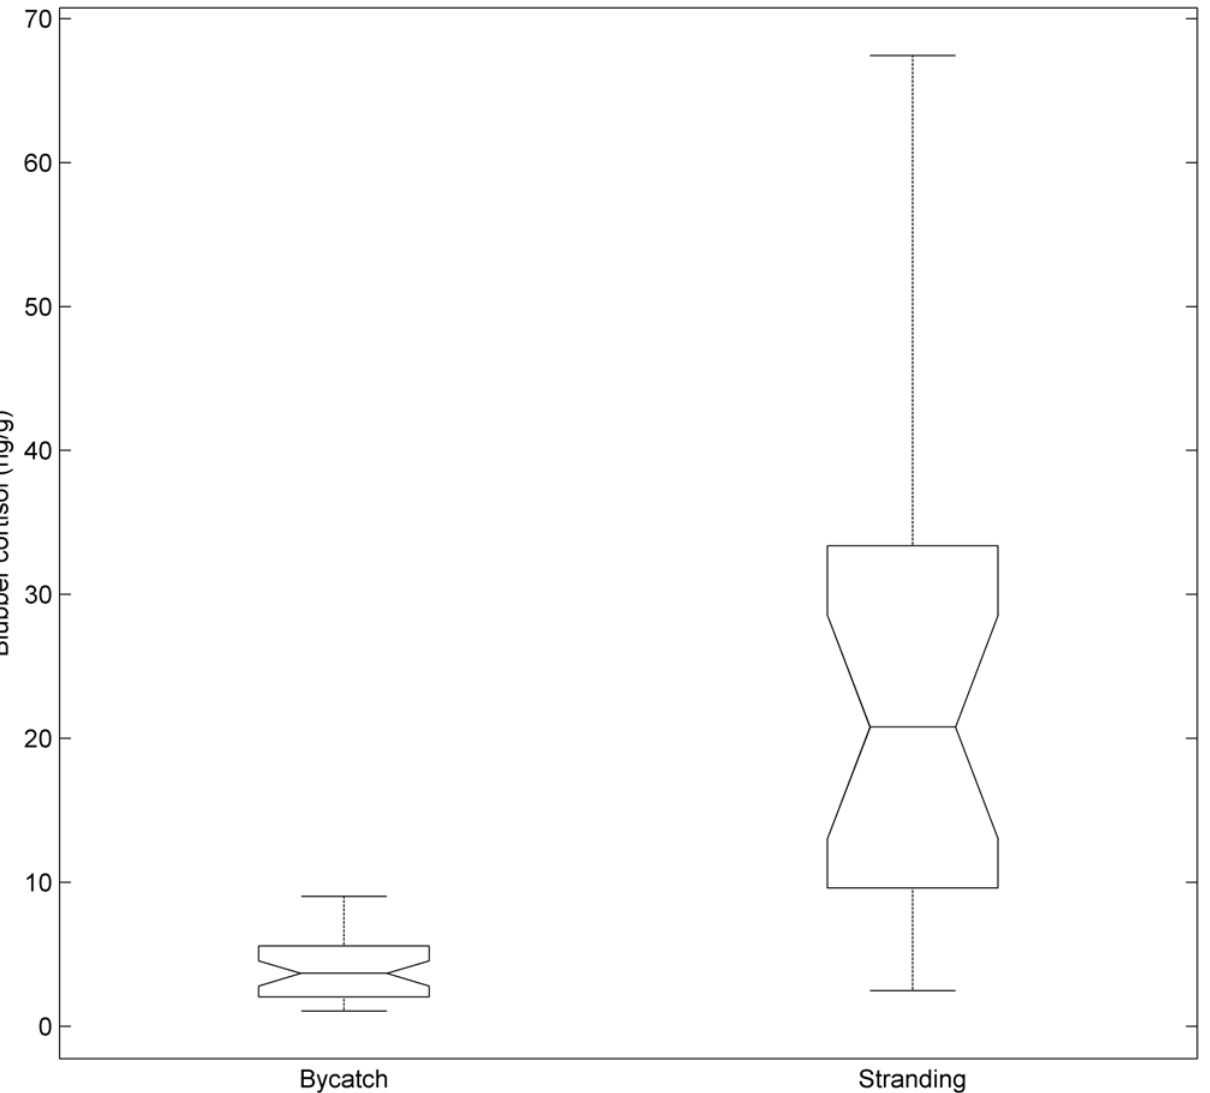
Fig 3. Blubber cortisol concentrations for bycaught (n = 40) and beach stranded (n = 23) D . delphis . Horizontal box lines represent the lower quartile, median, and upper quartile values. Whiskers lines indicate range of concentrations. Points of inflection represent upper and lower bounds to the 95% confidence interval. Stranded individuals (24.3 ng/g) had on average 6.1 times more blubber cortisol than bycaught animals (3.99